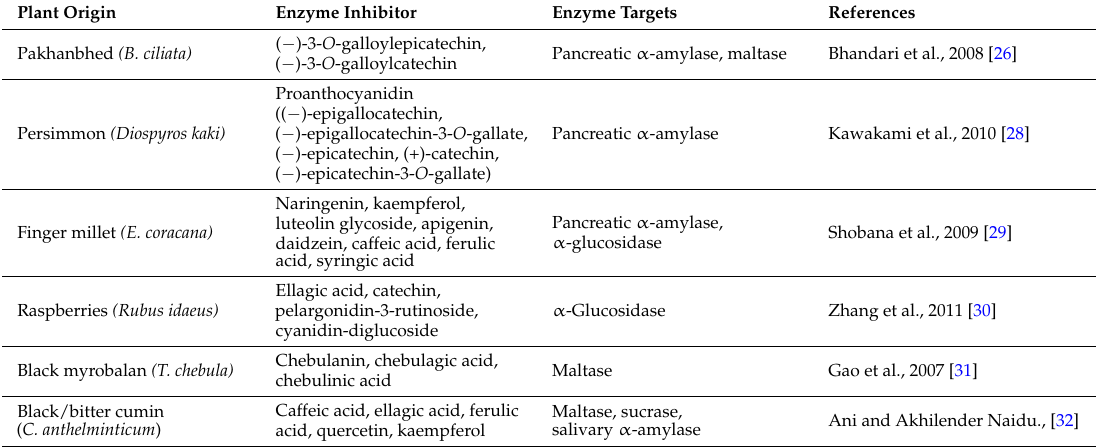
Table 2. Enzyme inhibitors from plant origins and their corresponding inhibition of enzymes in starch digestion.